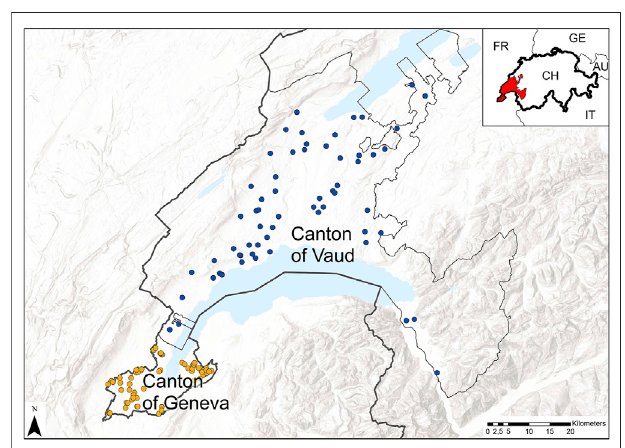
FIGURE 1 | Map of the study area and location of the sampled